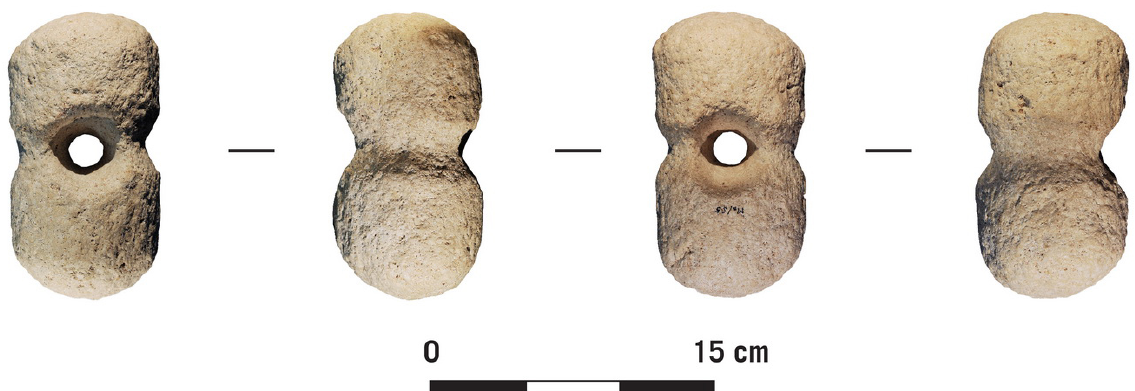
Figure 2. Lithic hammerstone ID 21149 observed in four different views. Its peculiarity is the joined presence of both the groove and the perforation realized within the groove itself; they were both functional to the hafting.